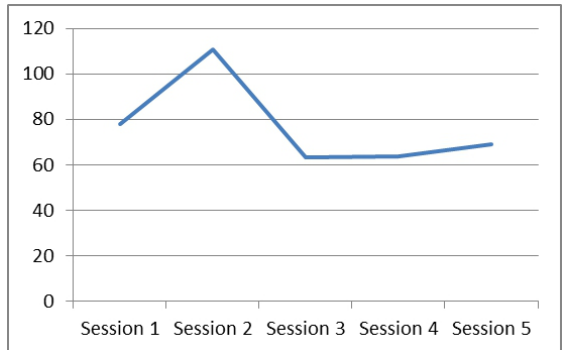
Figure 15. Participants’ number of petting events directed towards the AIBO robot over the 5 sessions in the AIBO